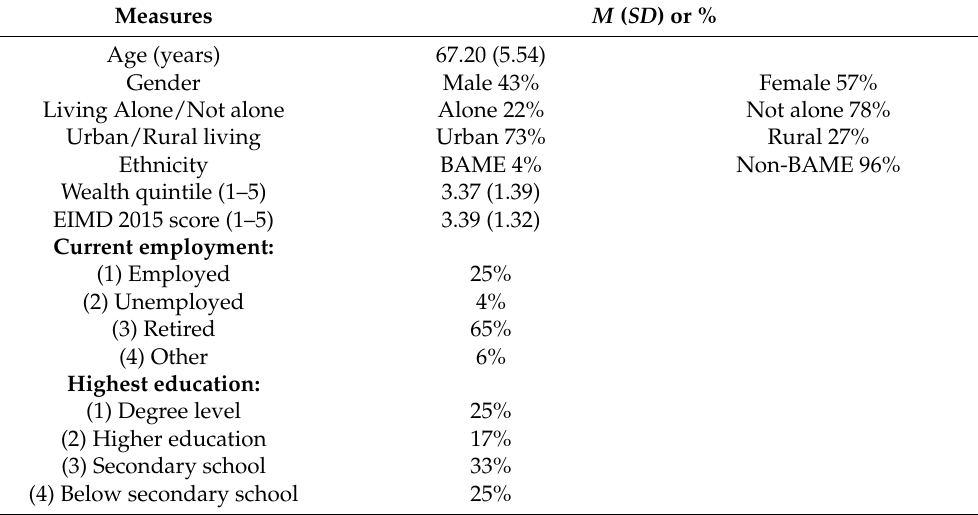
Table 1. Summary of Participant Characteristics ( n = 3500).